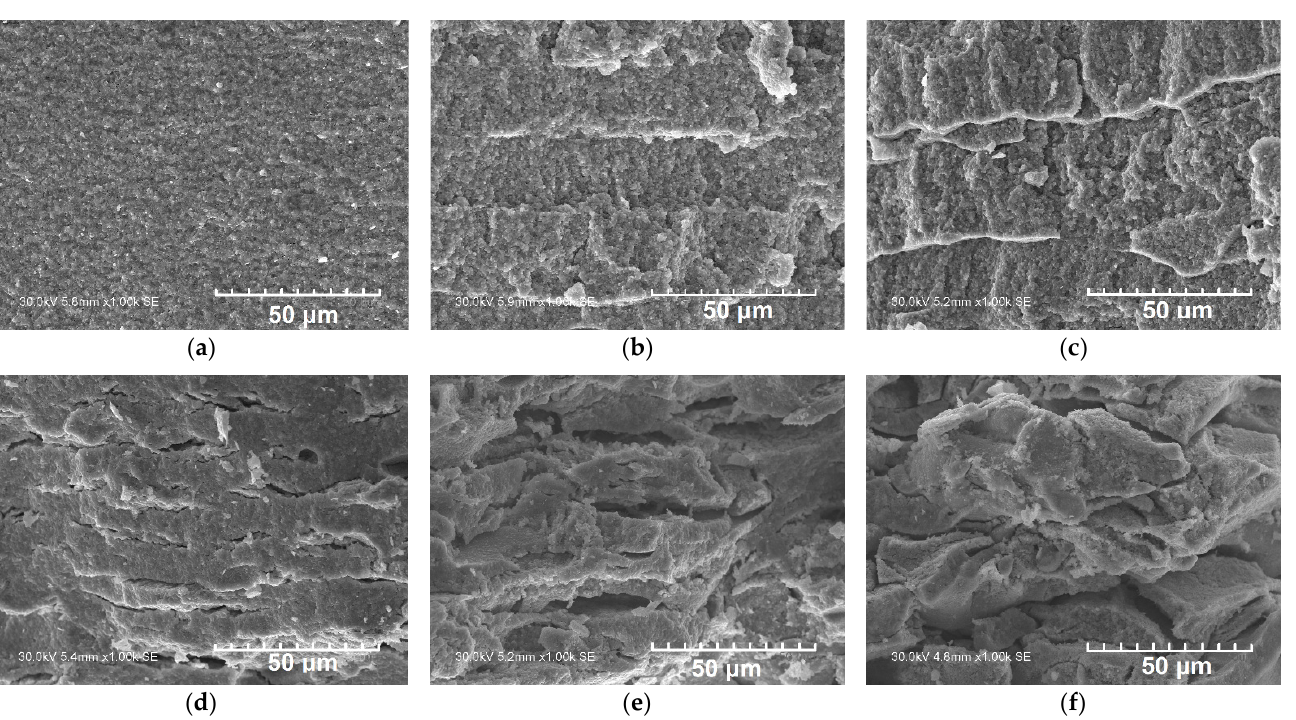
Figure 8. Photograph of NiO/YSZ anodes printed at different laser exposures before thermal sin- tering.